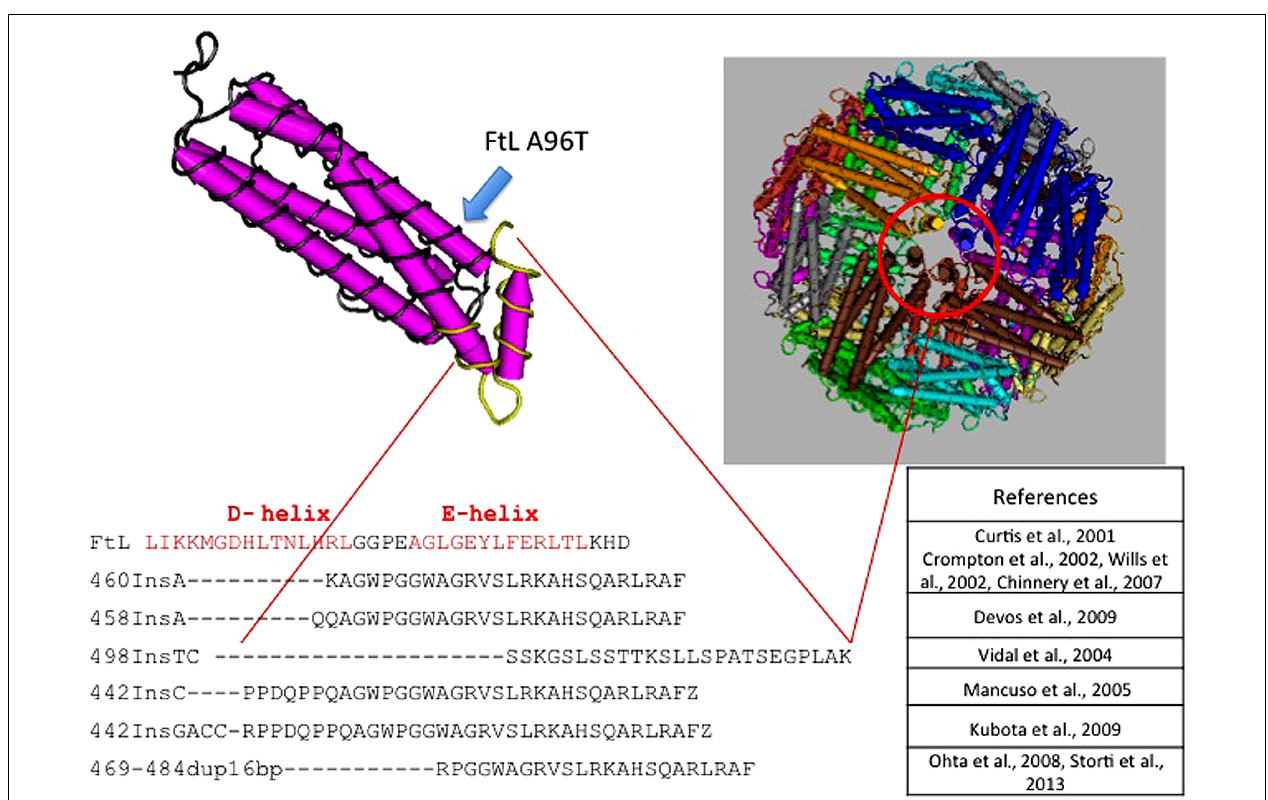
FIGURE 1 | Pile up of the C-terminus amino acid sequences of L-ferritin and the mutants causing neuroferritinopathy. All mutations, localized in the exon 4 of FTL, are nucleotide insertions that cause large alterations of the C-terminal region of the subunit.